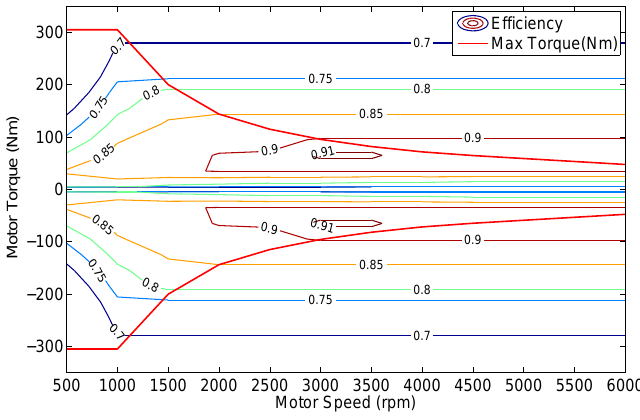
Figure 5. The electric machine (EM) efficiency